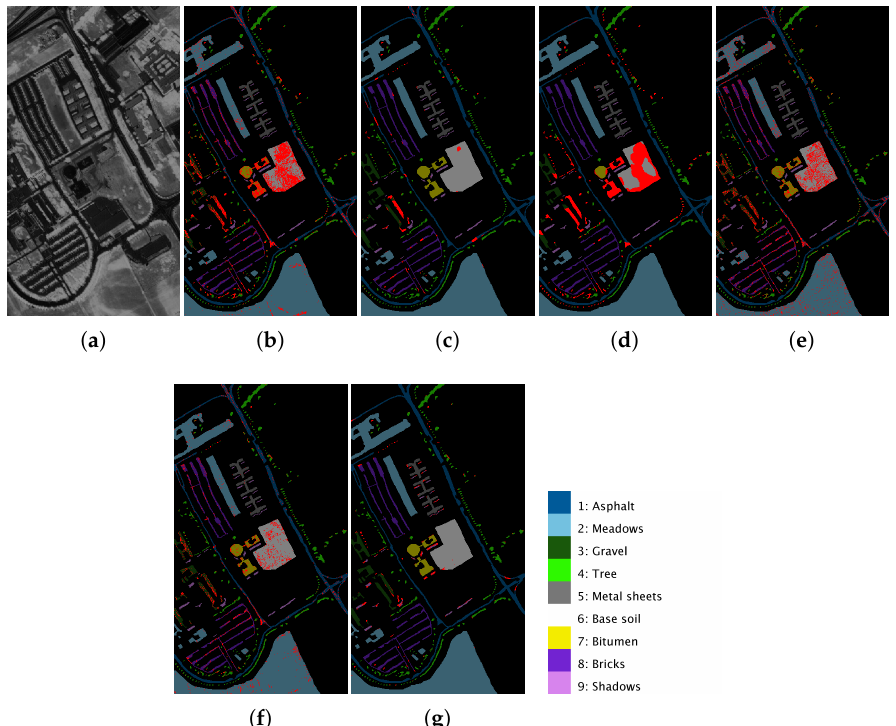
Figure 12. 2D angular transformation of the original hyperspectral image ( a ) and the results of the application of MLR ( b ); ppMLR ( c ); MLRpr ( d ); CRNN ( e ); SVM ( f ); and ECAS-II-SVM ( g ) classification methods to the Pavia scene. Misclassified pixels are marked with red dots. The classification methods have been trained using 3% of the samples of each class.